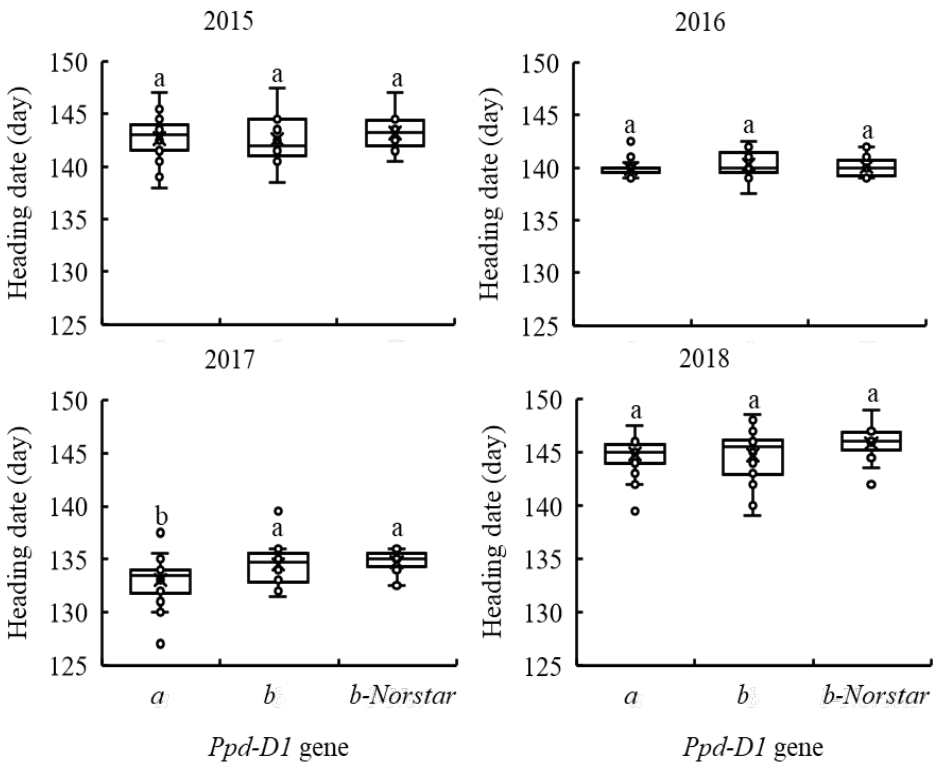
Figure 2. Heading dates of 86 eastern U.S. soft winter wheat genotypes with different alleles at the Ppd-D1 gene in four crop years. b-Norstar , ‘Norstar’-type sensitive allele. x indicates the mean. Means with different letters are significantly different at p < 0.05.